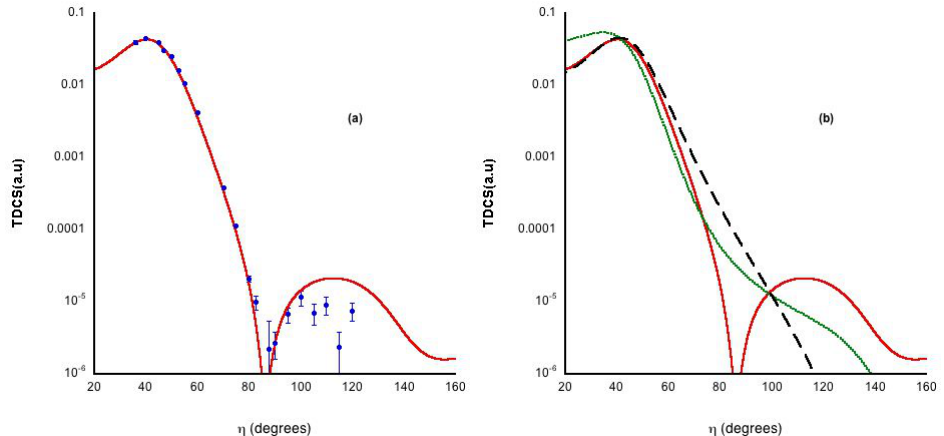
Figure 3. TDCS for the ionization of helium in coplanar symmetric geometry (i.e., Φ = 0 ◦ ) for E 0 = 200 eV. ( a ) Electron impact: experiment [25], theory DWBA (singlet exchange potential), no polarization no pci, experiment was relative and has been normalized to give the best visual fit to the DWBA; ( b ) Comparison of the TDCS calculated in the DWBA for positron: dotted green line, for electron: DWBA, solid red and the model calculation, DWDWPW, dashed